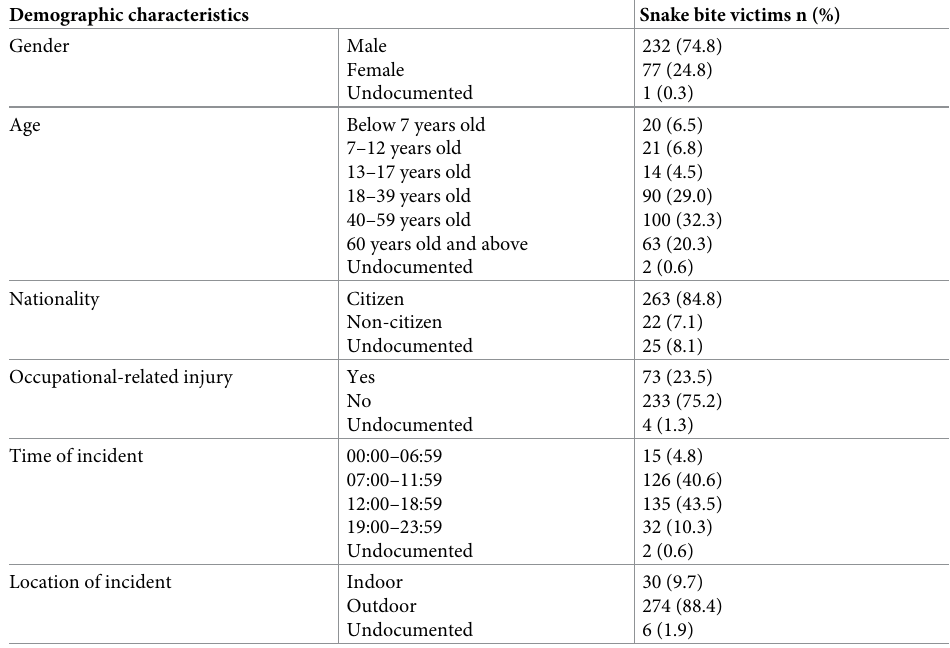
Table 1. Demographic characteristics of the Tropidolaemus spp. snake bite